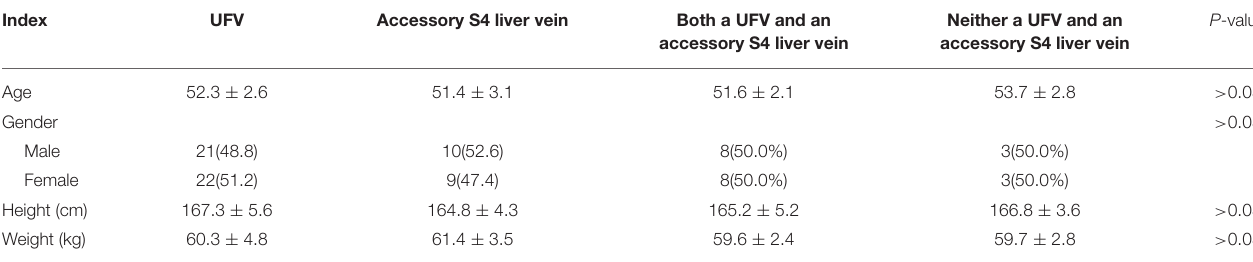
TABLE 1 | Comparison of different anatomical morphology of hepatic vein and the general data of